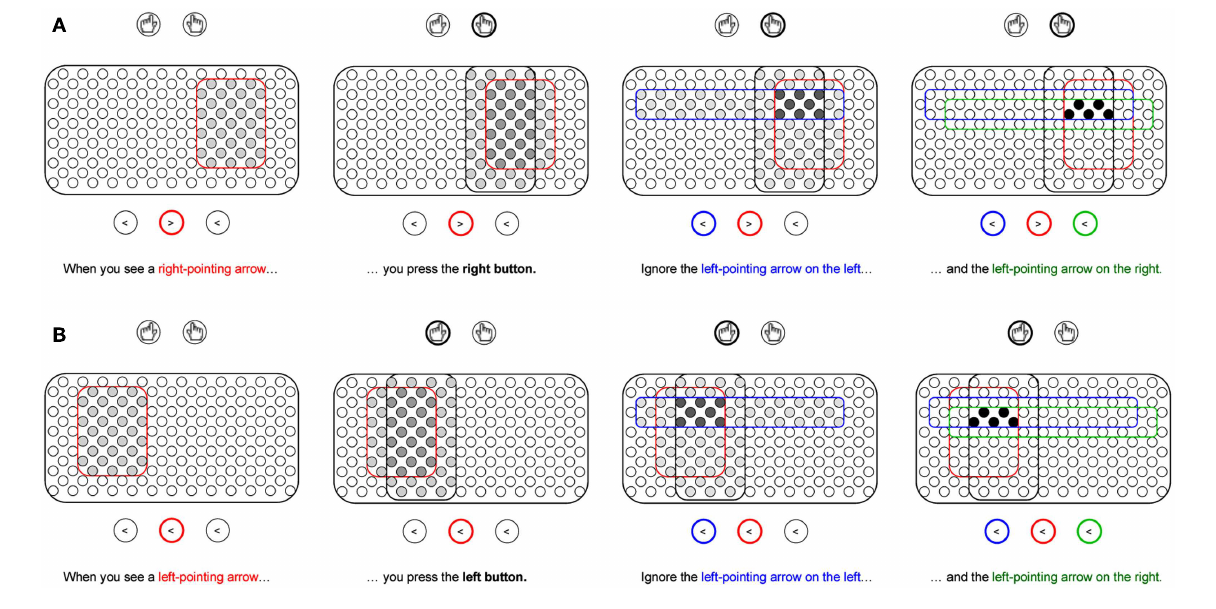
FIGURE 2 | Development of task representations in the flanker task. (A) instruction for incongruent trials. (B) instruction for congruent trials.When the instructions are given, a subset of a pool of uncommitted neurons gets activated.With every new phrase in the instruction, overlapping pools of neurons are activated, but only those neurons in the overlapping region